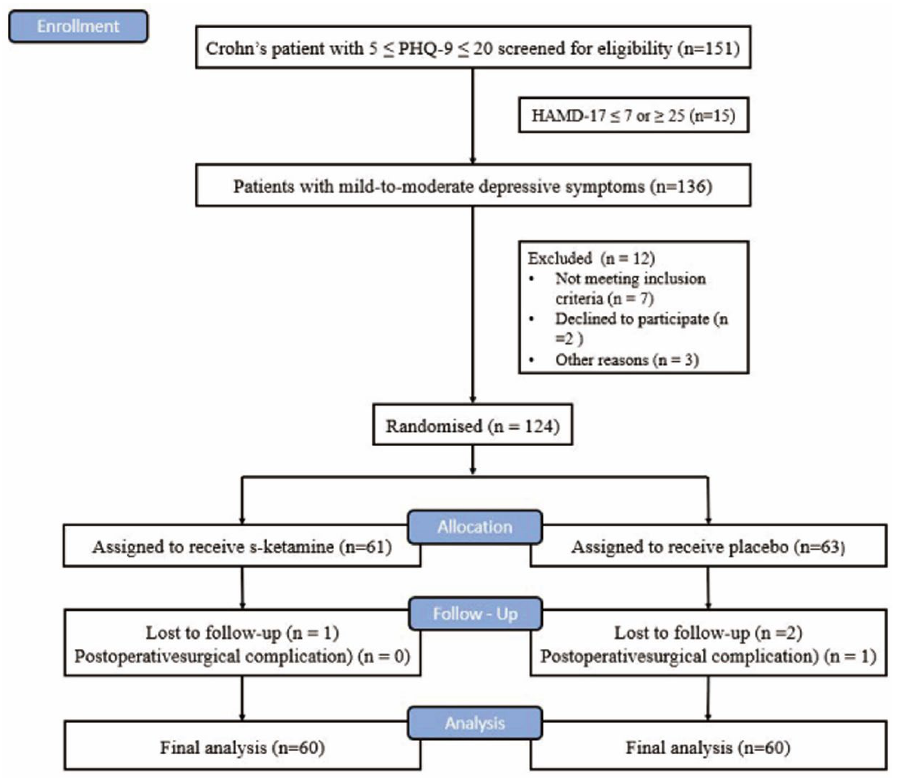
Figure 1. CONSORT flow chart. Table 1. Baseline characteristics.